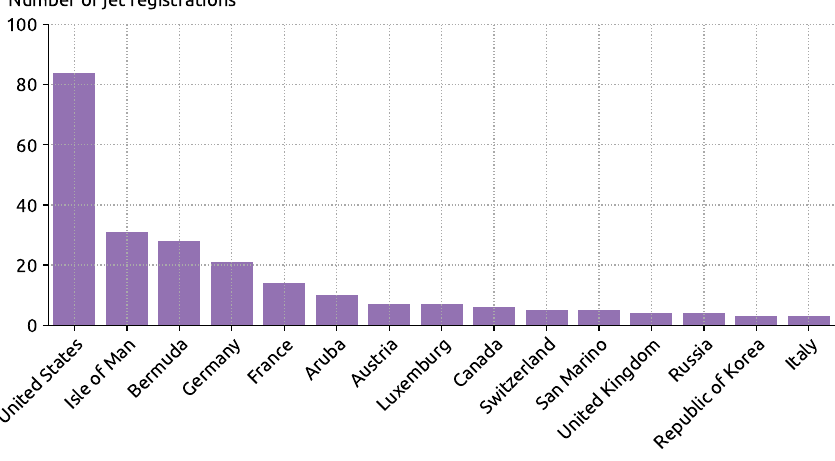
Figure 2. Top 15 countries for private and business jet registrations in our